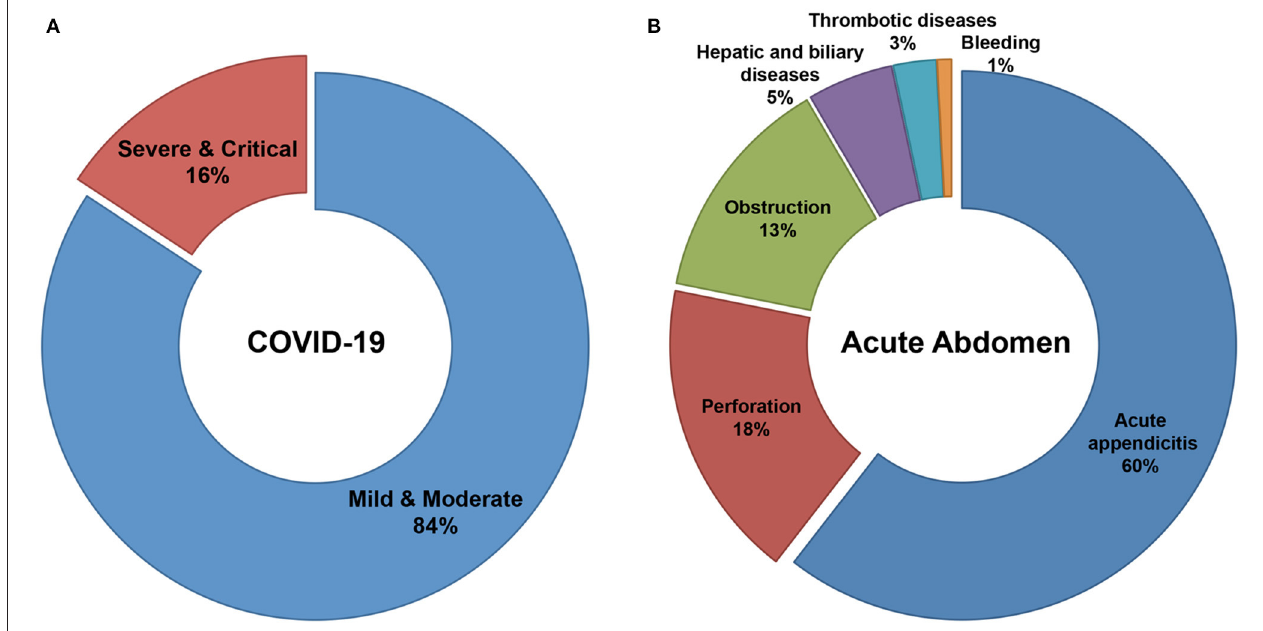
FIGURE 1 | Distribution of severity in COVID-19 patients and disease spectrum in infectious acute abdomen patients. (A) . 16% of enrolled COVID-19 patients were severe or critical and the left 84% were mild or moderate. (B) . The disease spectrum of enrolled infectious acute abdomen patients showed the top three causes for